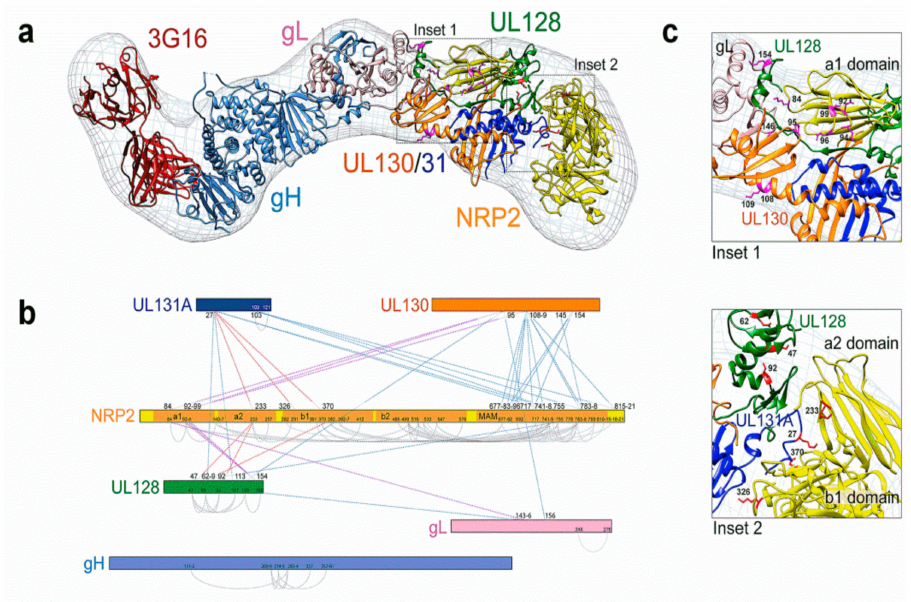
Figure 3. ( a ) Molecular architecture of the HCMV pentamer / Nrp2 / mAb 3G16 Fab complex. ( b ) Several cross-links were observed between the Nrp2 a1 domain and residues of pUL130, pUL128, and gL. Additional cross-links were observed between the a2 and b1 domains and residues of pUL131 and pUL128. ( c ) Interactions between the HCMV pentamer complex (PC) and a2-b1-b2 domains of Nrp2 are observed in Insets 1 and 2 (from [72]).